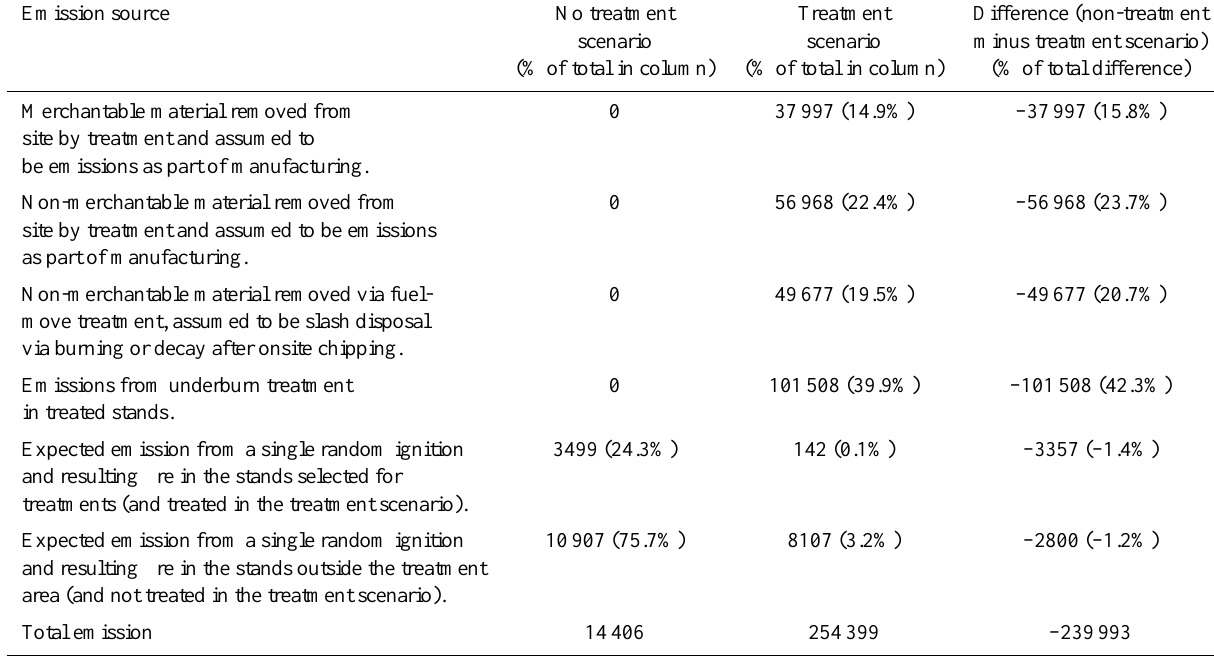
Table 4. Partitioning of carbon emissions (tonnes) on the forested portion of the study area for the treatment and non-treatment